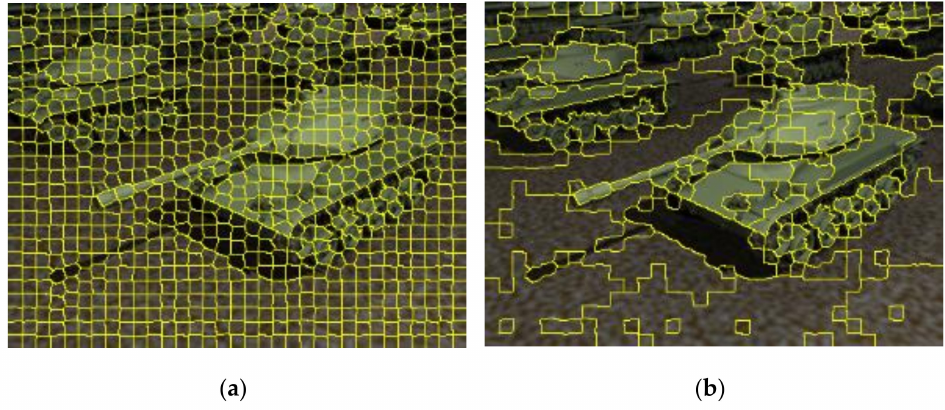
Figure 2. Example of segmented results: ( a ) SLIC segmentation, n 0 = 800, and ( b ) merging of ( a